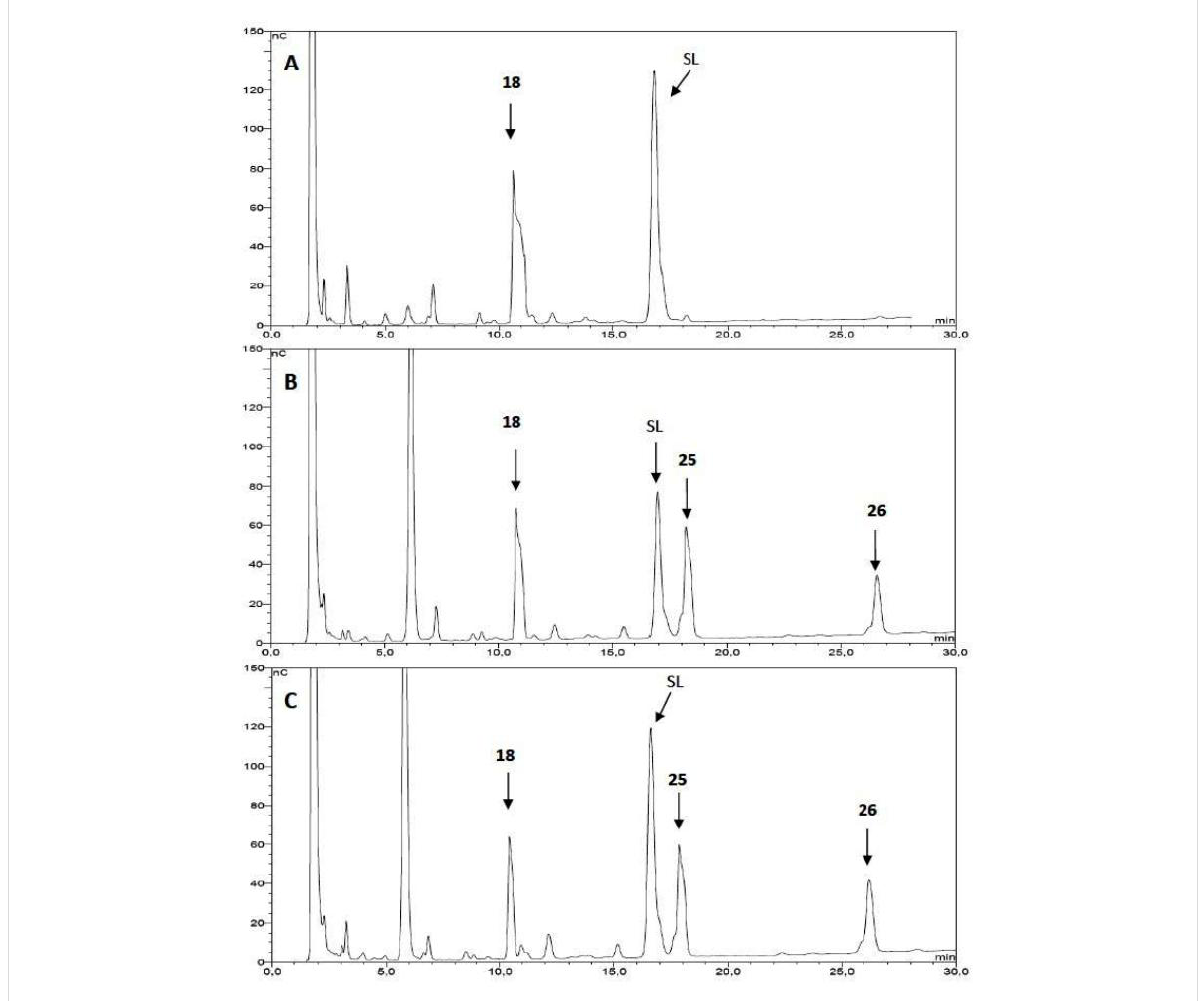
Figure 1: Analysis of 18 as acceptor substrate of TcTS . A: 18 (1 mM) and 3’-sialyllactose (SL, 1 mM), without enzyme; B: 18 (1 mM) was incubated with SL (1 mM) and TcTS for 15 min at 25 °C; C: the same as B but using 2 equivalents of SL (2 mM). The incubation mixtures were analyzed by HPAEC using a CarboPac PA-10 ion exchange analytical column eluted with a linear gradient over 30 min from 20 to 200 mM NaAcO in 100 mM NaOH at a flow rate of 0.9 mL/min. Structures for compounds 18 , 25 and 26 are shown in Scheme